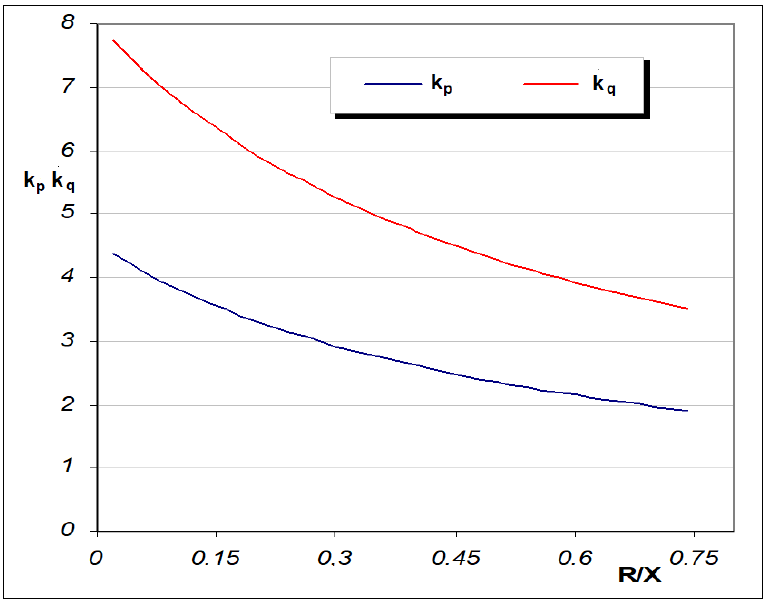
Figure 15. Changes in the inclination coefficients of the power–voltage characteristics as a function of the ratio of resistance to reactance supplying the arc device (operation at rated current).